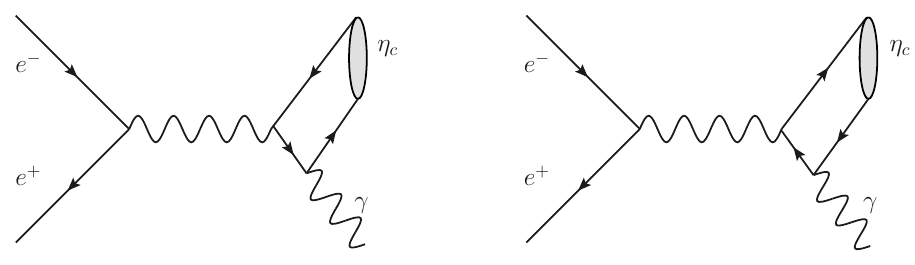
Figure 1 . Feynman diagrams for the process e + e (cid:0)